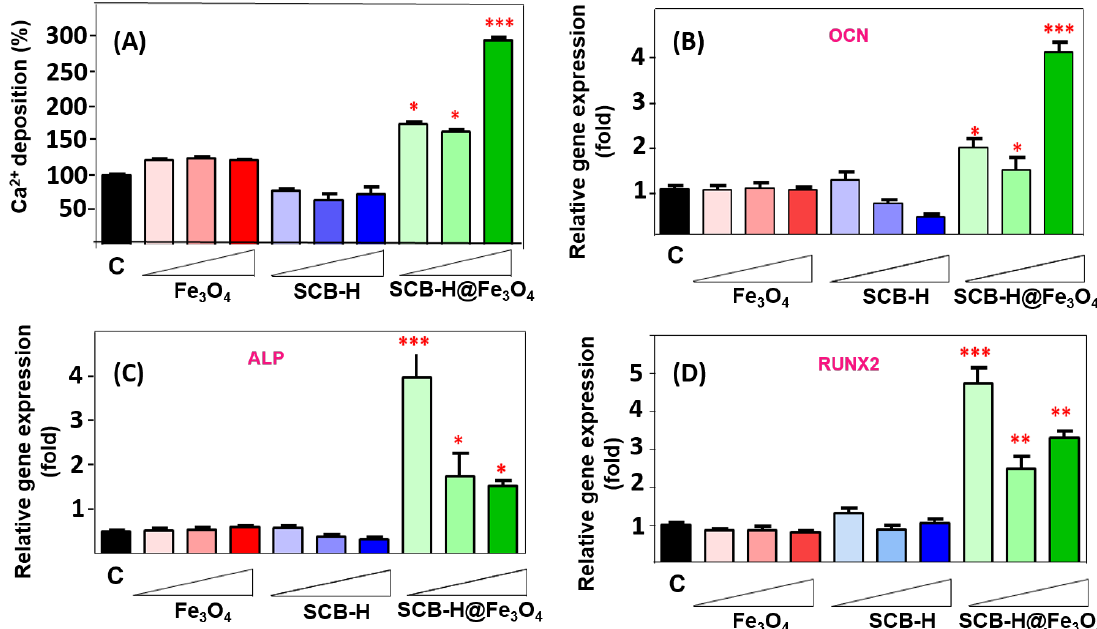
Figure 5. Quantification of osteogenesis. hADMSCs were differentiated to osteoblasts for 14 days in osteogenic induction media with or without nano-scaffolds. After differentiation, the osteogenic markers were quantified by using ARS staining and real-time RT PCR. ( A ) Quantification of ARS staining. ( B – D ) mRNA level of osteogenic marker. C: vehicle, nano-scaffolds concentration from 25, 50 to 100 µg/mL for every sample of bare Fe 3 O 4 , SCB-H, and SCB-H@Fe 3 O 4 . * p < 0.05, ** p < 0.01 *** p < 0.001 in comparison with untreated cells.